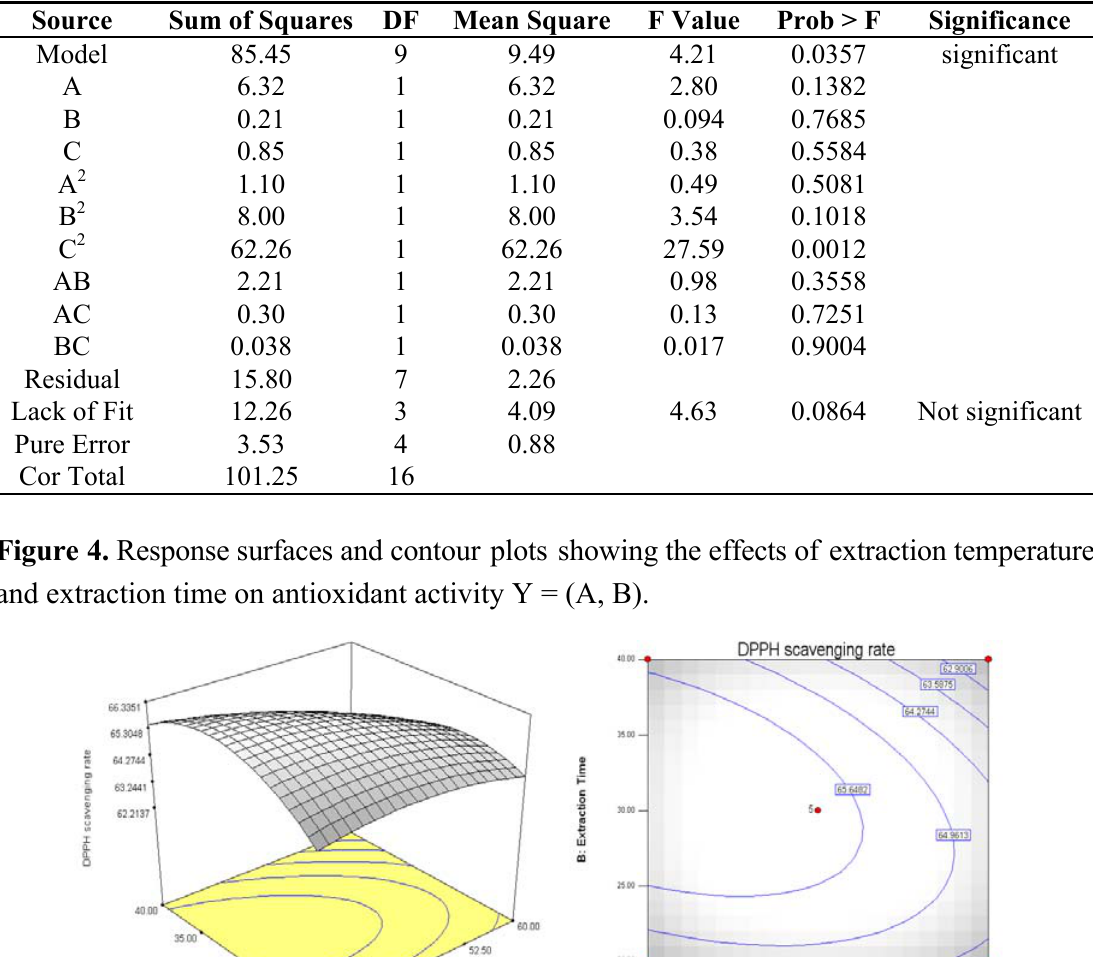
Table 2. Analysis of variance for response surface quadratic model.